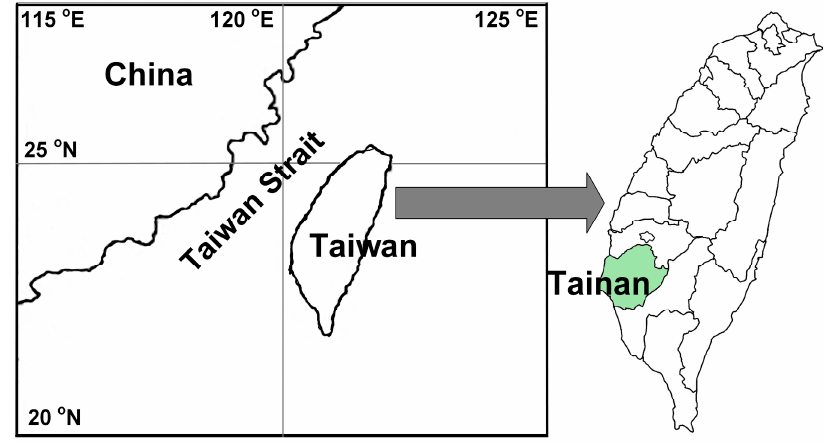
Figure 1. Map of Tainan, Taiwan.